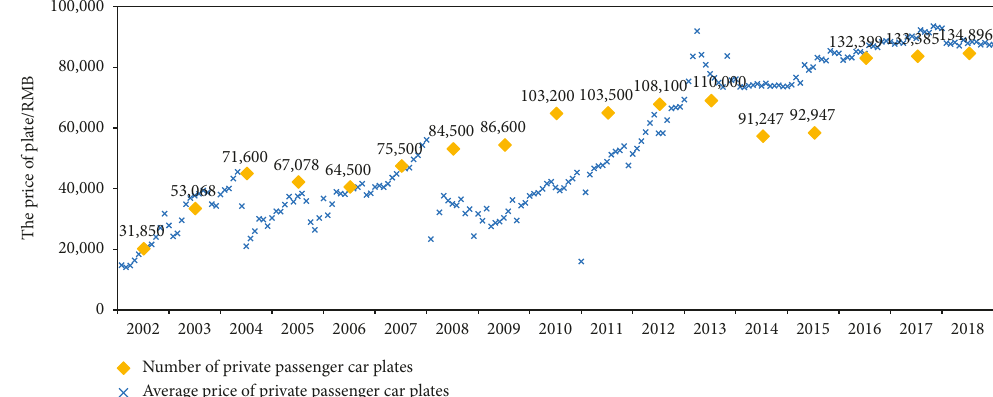
Figure 7: Number and average price of private passenger car plates in